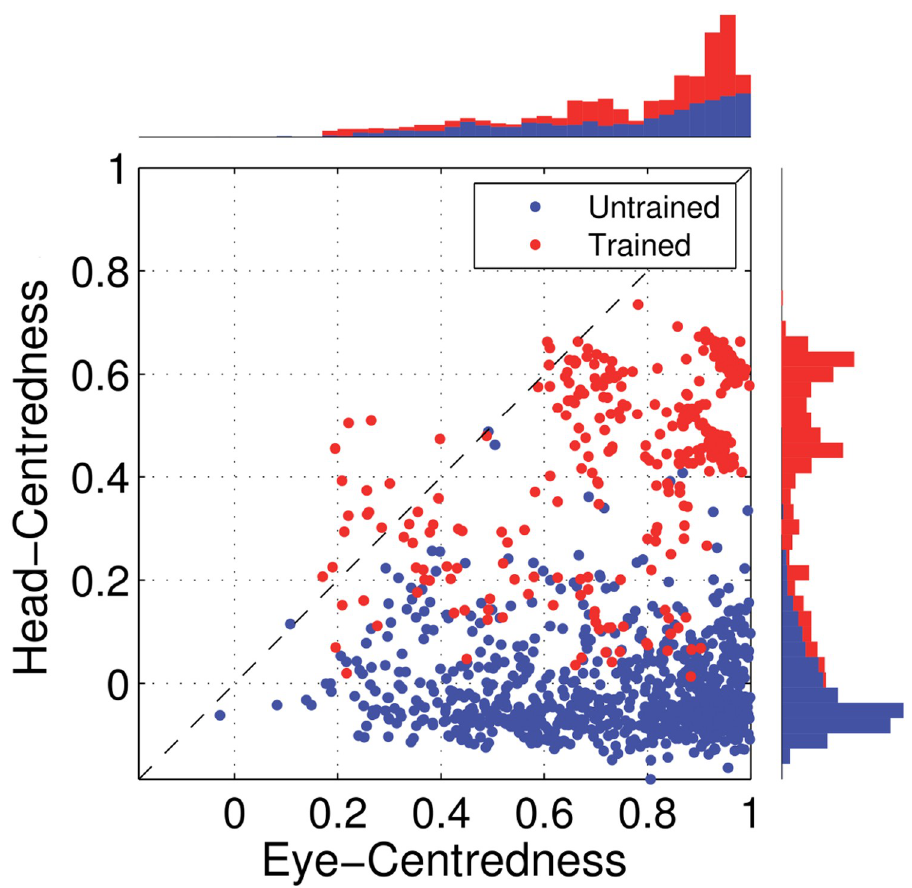
Fig 20. Simulation results showing the output reference frame response characteristics of a model incorporating a population of sigmoidal modulated input neurons trained with the modified learning rule 19: Current postsynaptic trace with anti-Hebbian learning. The scatter plot shows the reference frame response characteristics of all output neurons before and after training. Conventions as for Fig 14. It can be seen that training increased the head- centredness values of most output neurons, with quite a number of head-centred output neurons present in the trained model.